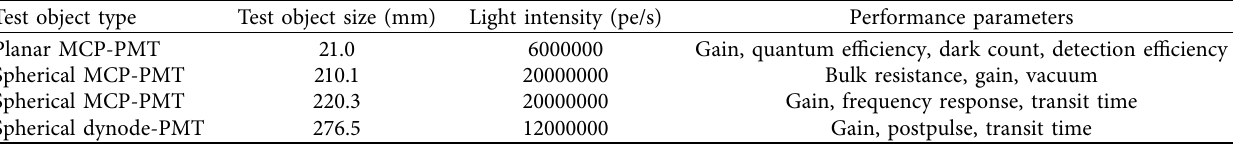
Table 1: Comparison of the signal aging test systems of photoelectric devices.